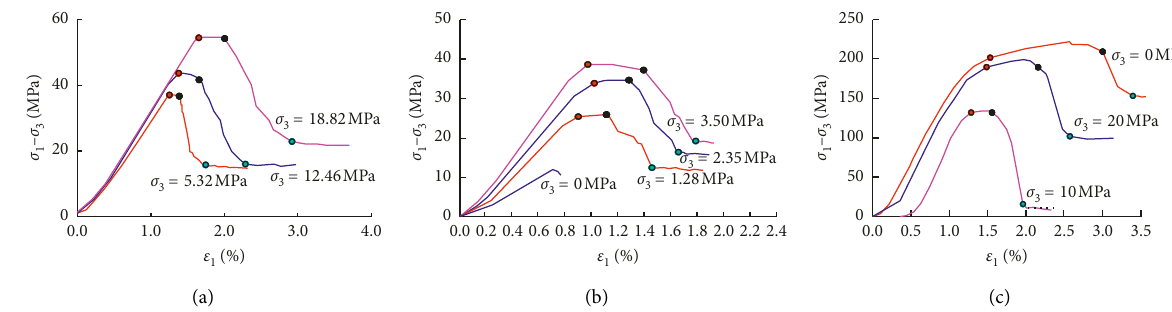
Figure 2: The total stress-strain curves by different lithology rock masses. (a) Silty mudstone from Yangzhuang coal mine. (b) Silty mudstone from Wushan. (c) Marble from Ya’an area of